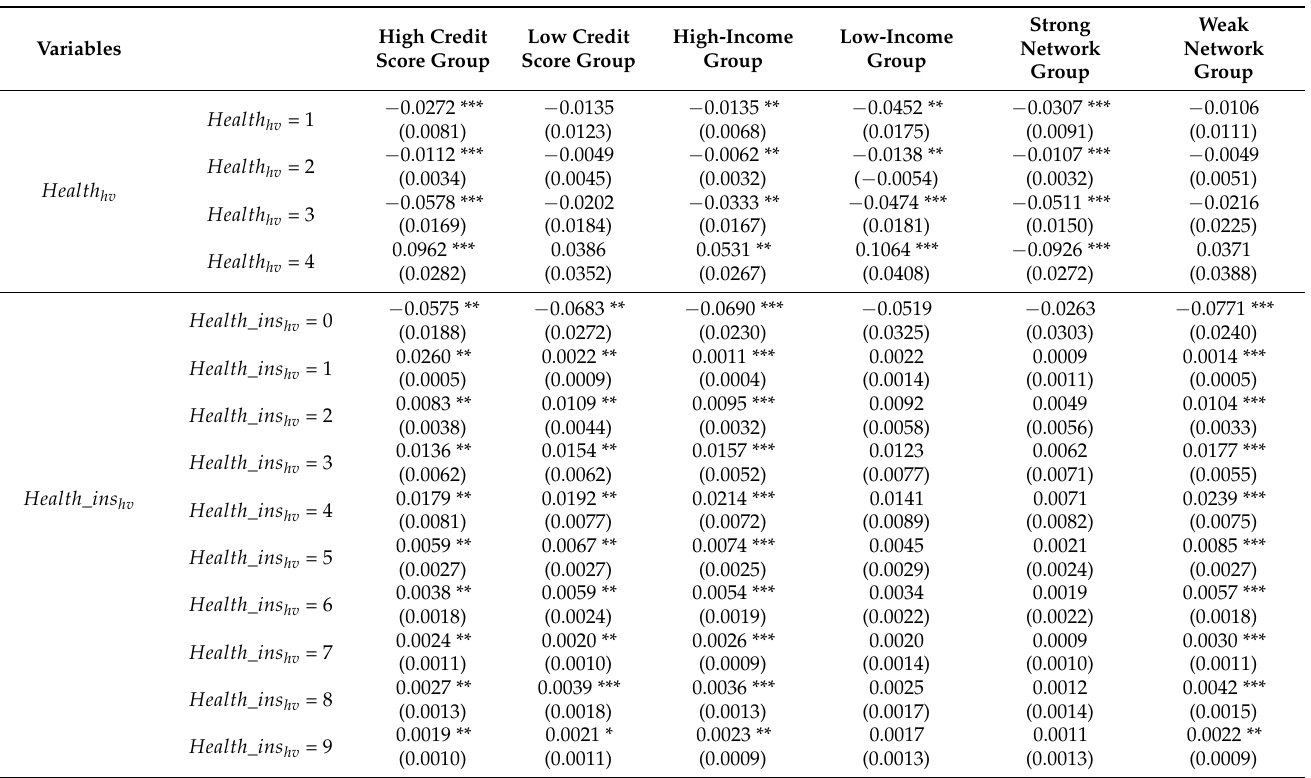
Table 7. The marginal effects of microcredit on rural residents’ health in different groups.